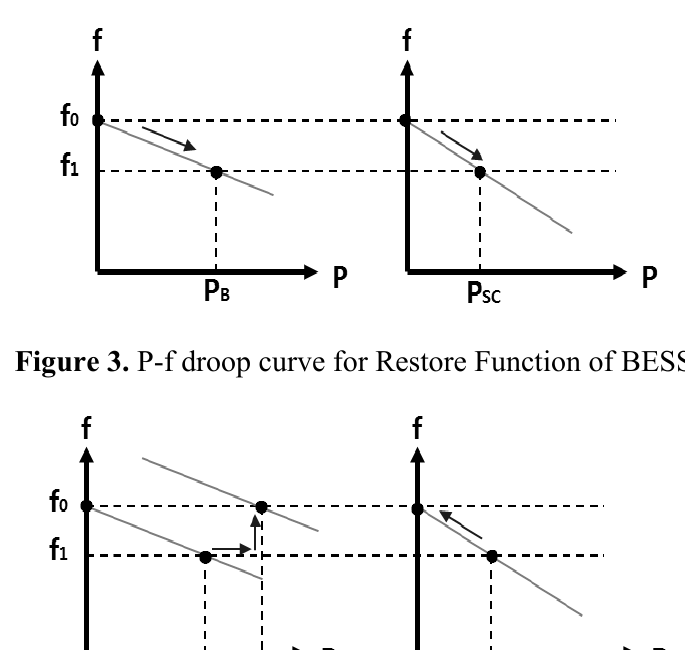
Figure 2. P-f droop curve for UPC Mode of BESS and SC.